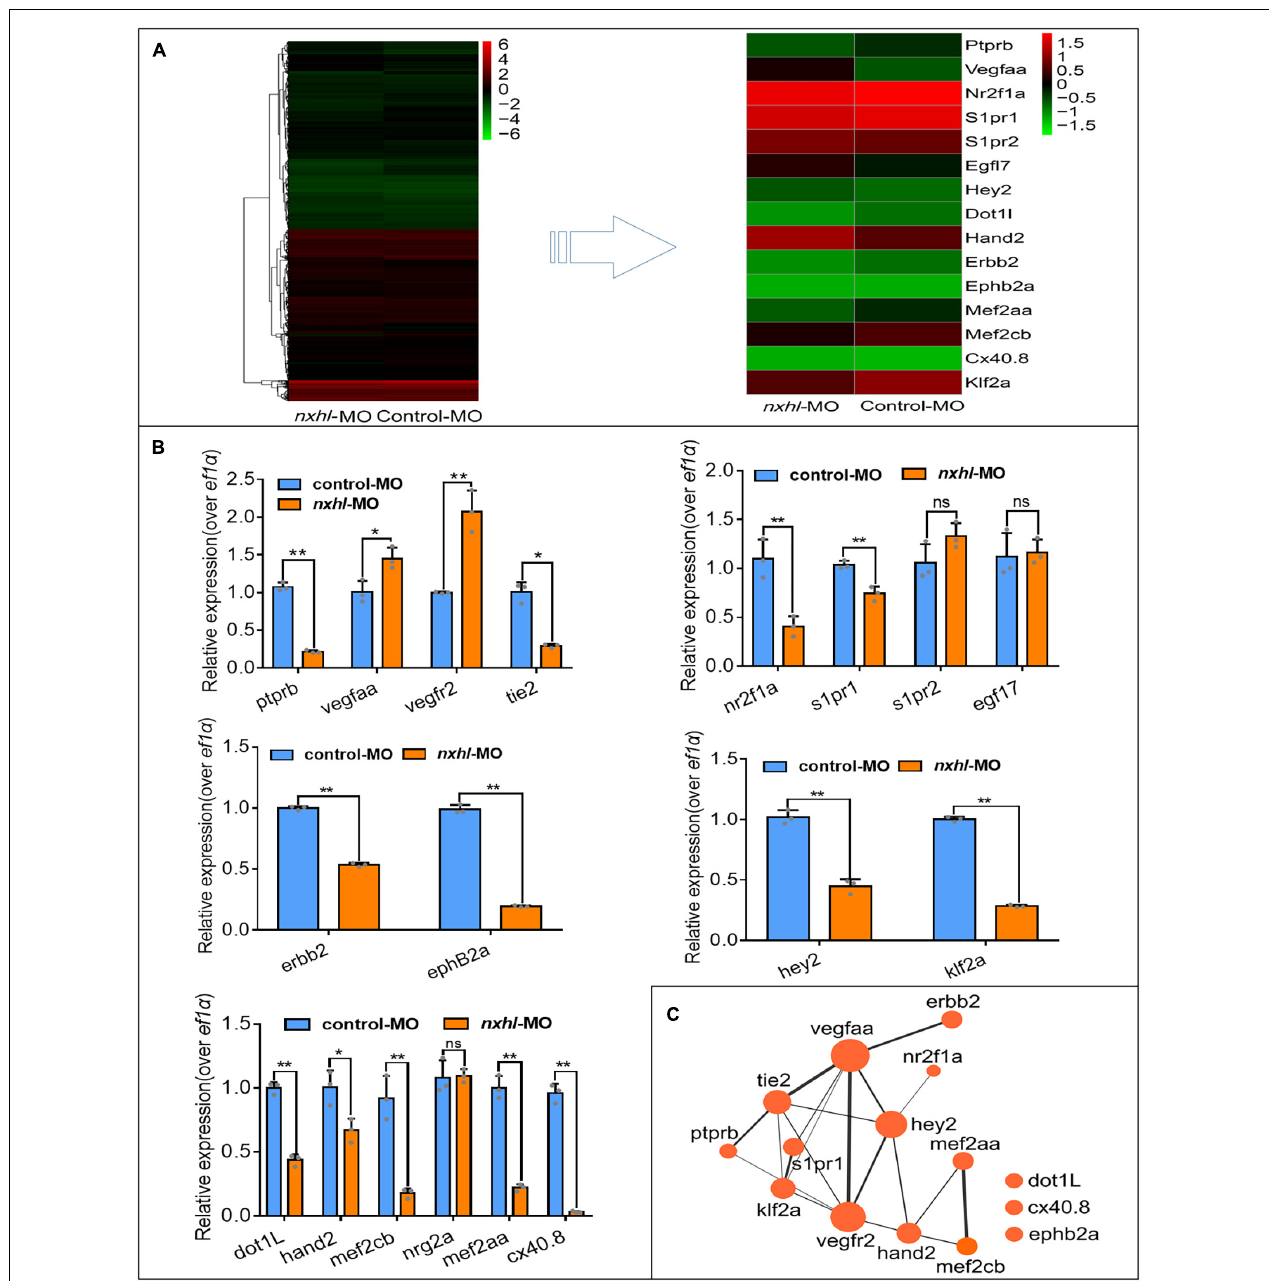
FIGURE 4 | Nxhl modulates ptprb expression and angiogenic networks. (A) Heatmap of the 15 selected genes from zebrafishes after injection of 4 ng nxhl e1i1 MO at 3-dpf examined by RNA-seq. (B) Expression of genes associated with angiogenesis and /or heart development post injection of nxhl e1i1 MO 3-dpf using qPCR. The data above represent as mean ± SEM from three independent experiments. Ns, non-significant, * p < 0.05, ** p < 0.001 represents statistically significant. (C) Networks of the genes previously reported to be associated with angiogenesis and heart development. Cytoscope V3.6.1 was used to build this